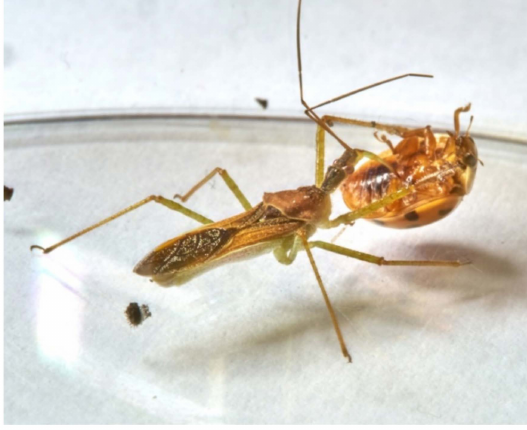
Figure 13. LAB male feeding on Harmonia axyridis